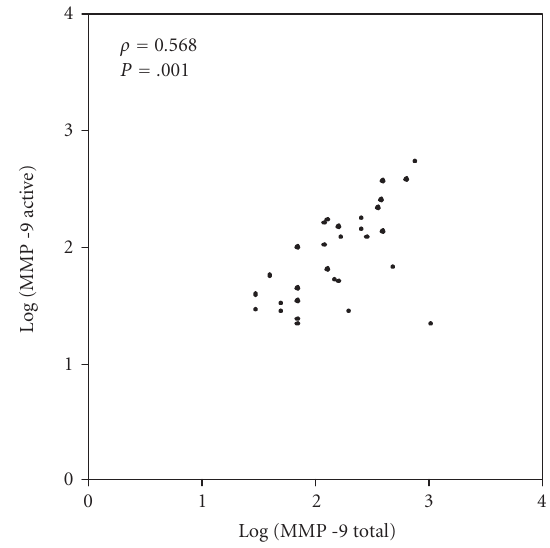
Figure 1: Correlations between total and active MMP-9 in SLE pa-